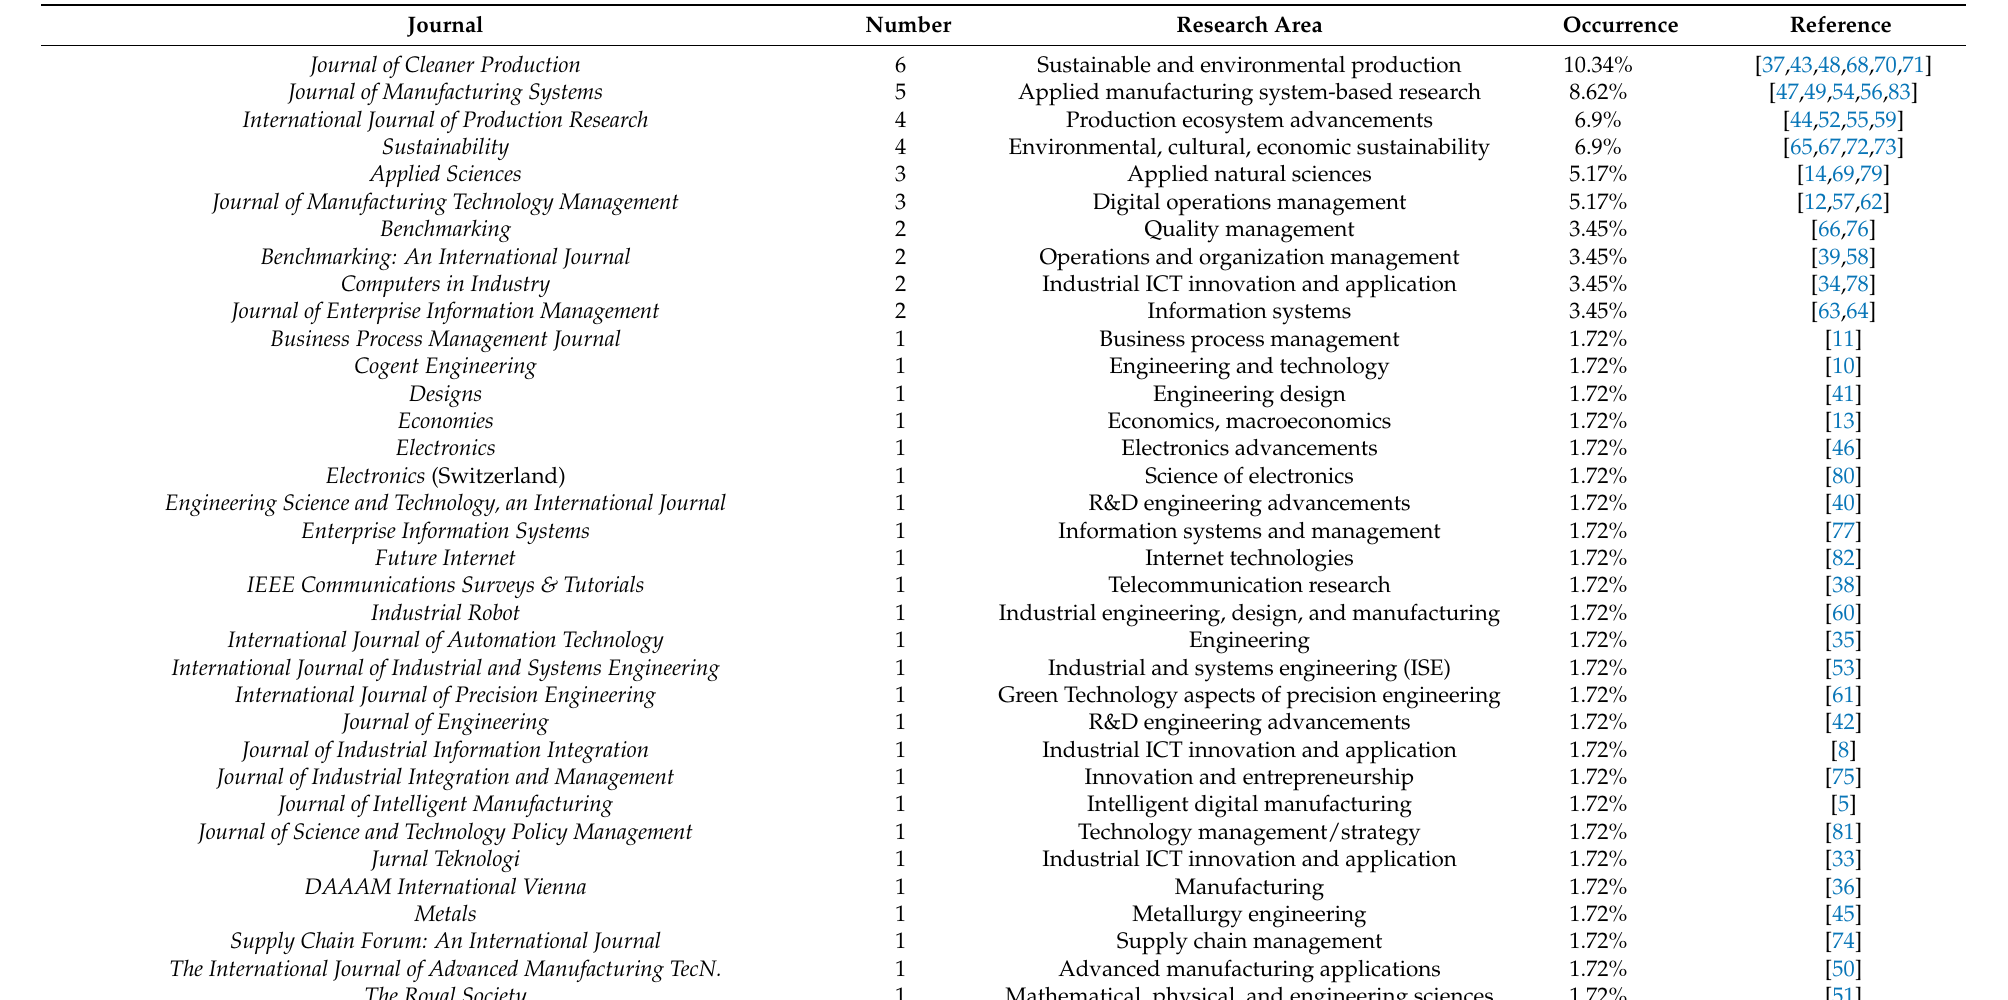
Table 3. This table includes the research areas of the journals and their